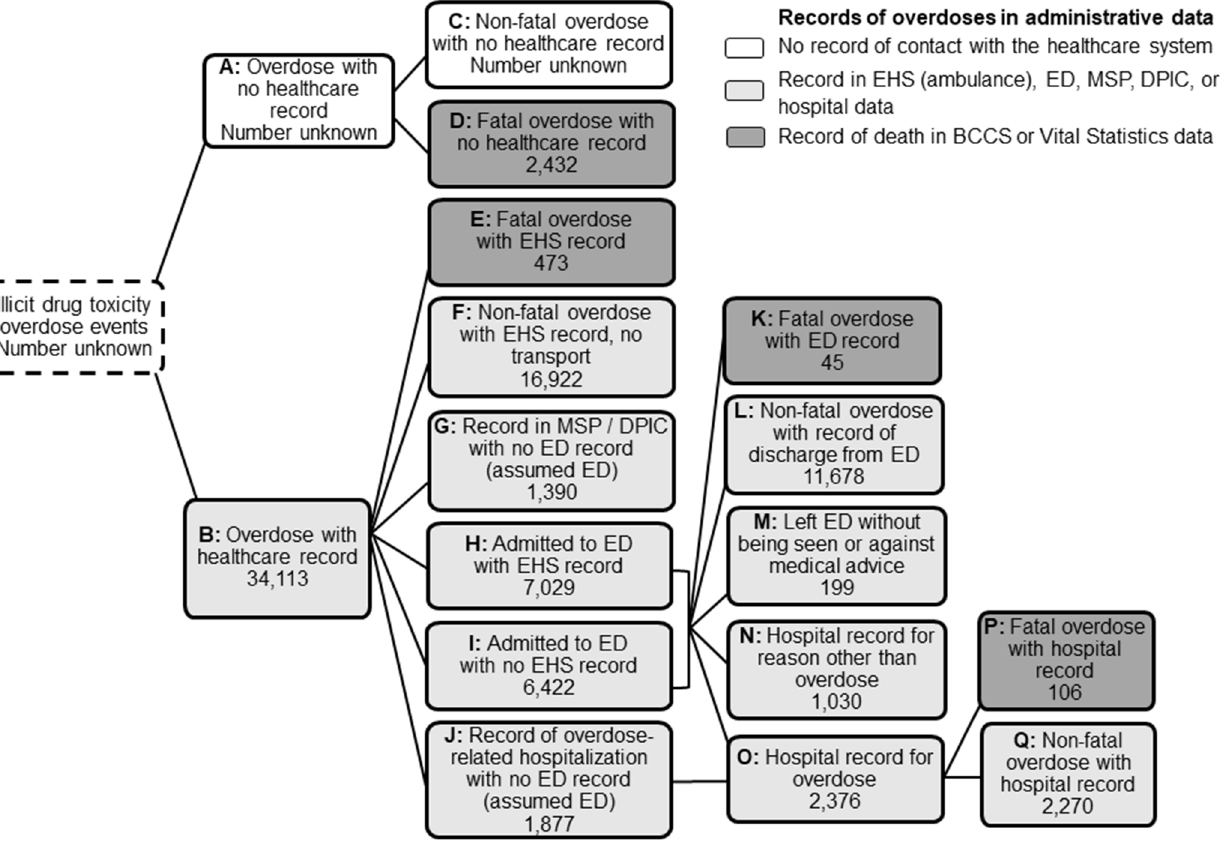
Figure 2: Pathways of care for overdose events, BC Provincial Overdose Cohort,